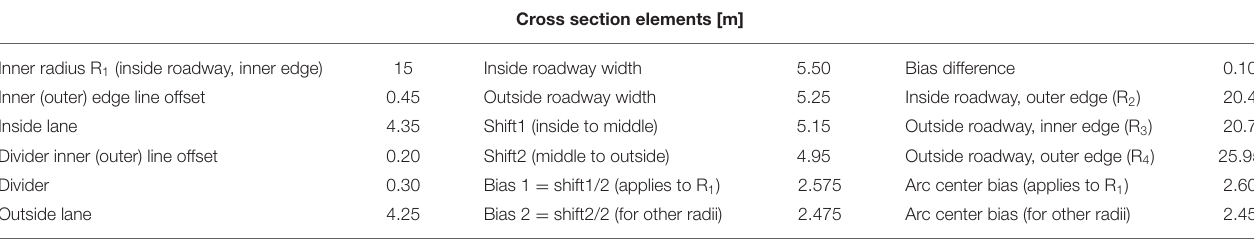
TABLE 1 | The geometry for the basic turbo